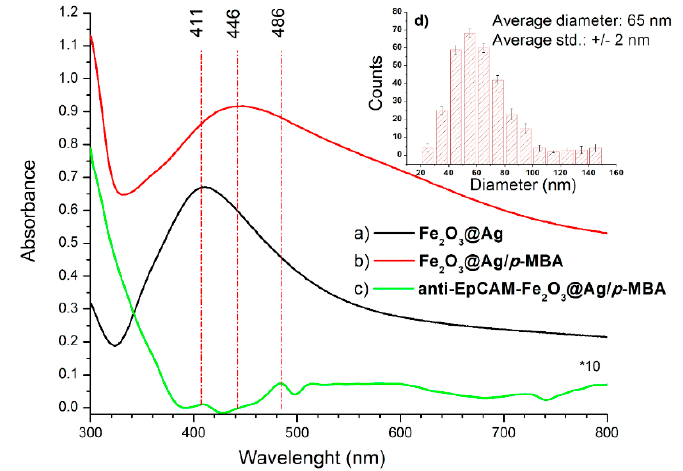
Fe 2 O 3 @Ag as-received, ( b ) after modification with Raman reporter ( p -MBA), ( c ) after mixing with